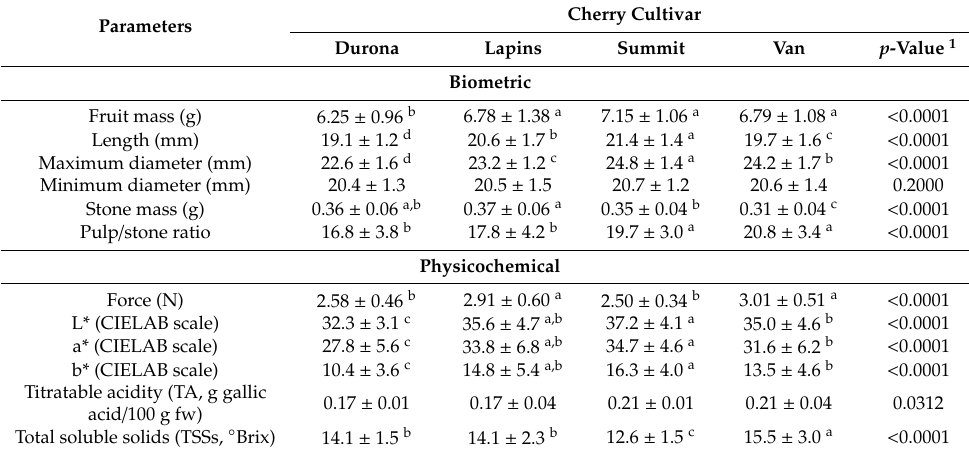
Table 1. Fruit biometric and physicochemical parameters (mean value ± standard deviation) of the four sweet cherry cultivars studied (Durona, Lapins, Summit, and Van) and statistical di ff erences (one-way